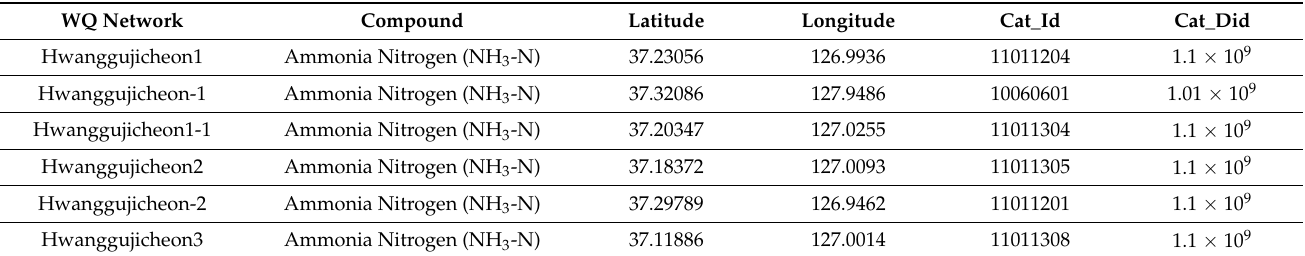
Table 1. Latitude and longitude of the area of